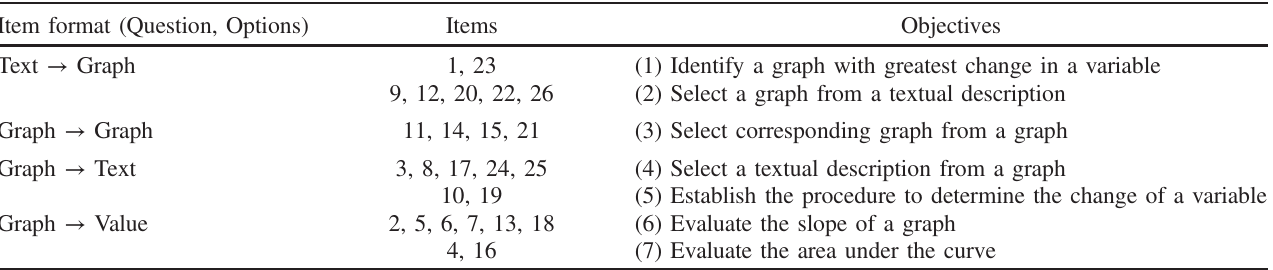
TABLE I. Overview of TUG-K item objectives and representational formats. Item format (Question,